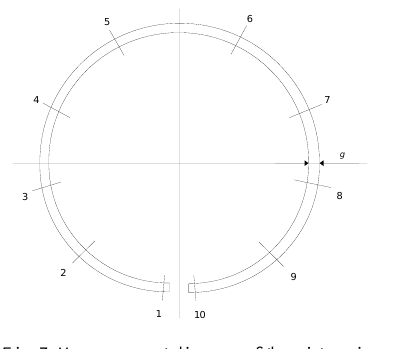
Fig. 7. Measurement diagram of the piston ring Table 3. Value of the axial height wearing of the rings after the test Ring Value of the axial height wearing of the rings after the test [µm] Num.